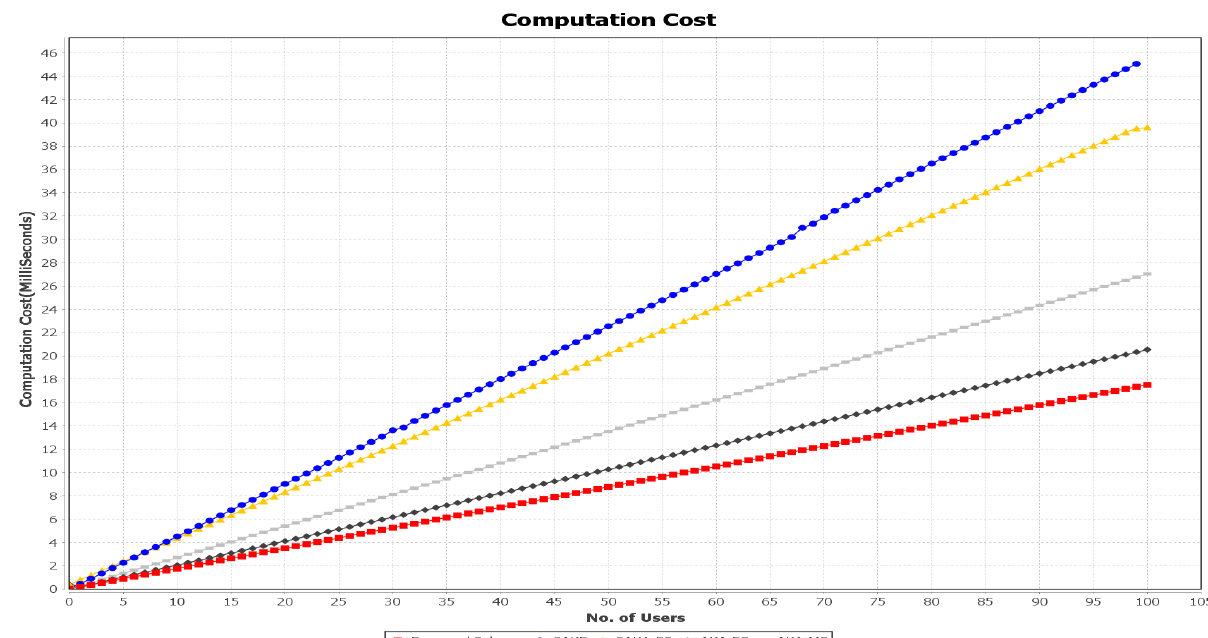
Figure 14. Computation costs comparison of SELAMAT against SAKA-FC, SAKE, AKA-FC, and